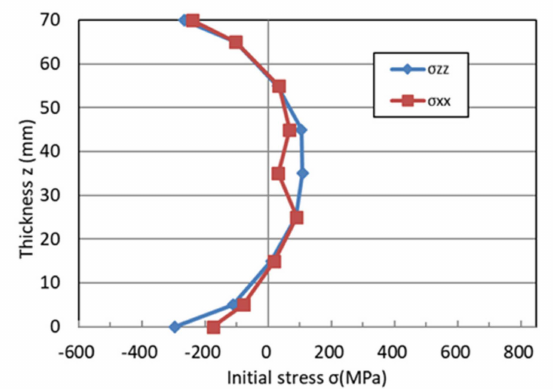
Figure 6. Initial stress by production